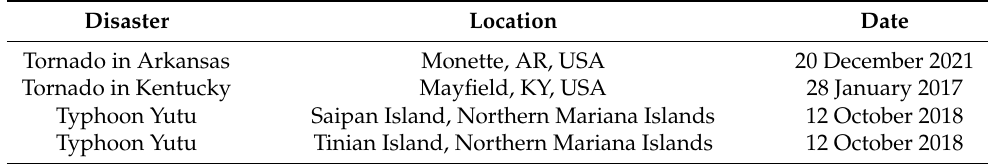
Table 3. Detailed information of the two